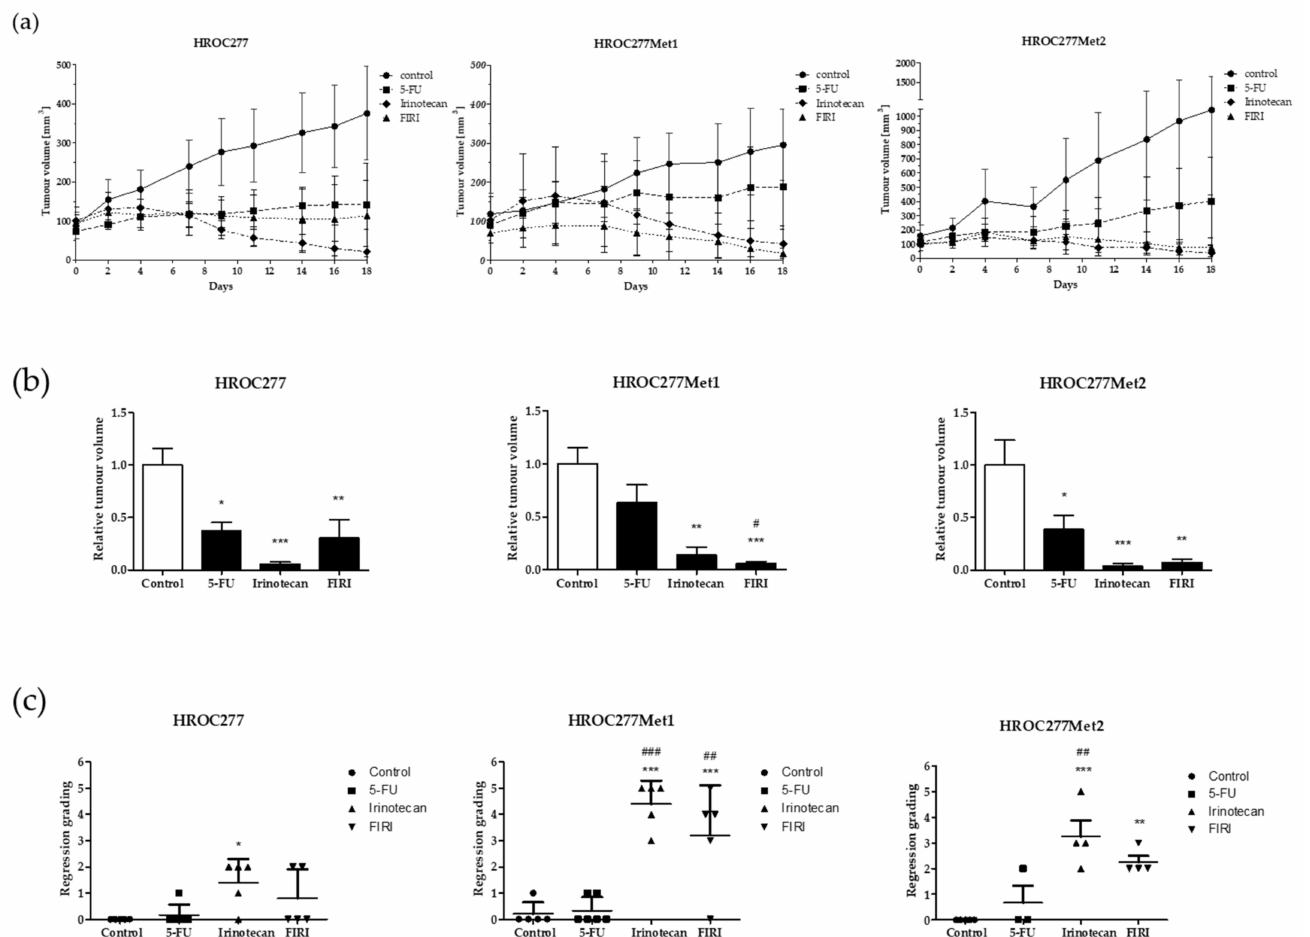
Figure 3. Chemosensitivity in vivo. Xenografted mice were treated with 5-FU (30 mg/kg bw), irinotecan (20 mg/kg bw), FIRI (5-FU 30 mg/kg bw and irinotecan 20 mg/kg bw) or 0.9% NaCl solution in the control group. Tumour volume was measured under therapy ( a ) and at day 18 ( b ). Regression grading ( c ) was performed by an experienced pathologist indicating 0: no histological response to therapy and 5: very strong therapy response. Results are depicted as mean with standard deviation. Statistical results are based on an ANOVA test indicating p -value <0.05 (* or #), p -value <0.01 (** or ##) and p -value <0.001 (*** or ###). * treatment group vs. untreated control group; # irinotecan- or FIRI-treated mice vs. 5-FU-treated mice. Bw: body